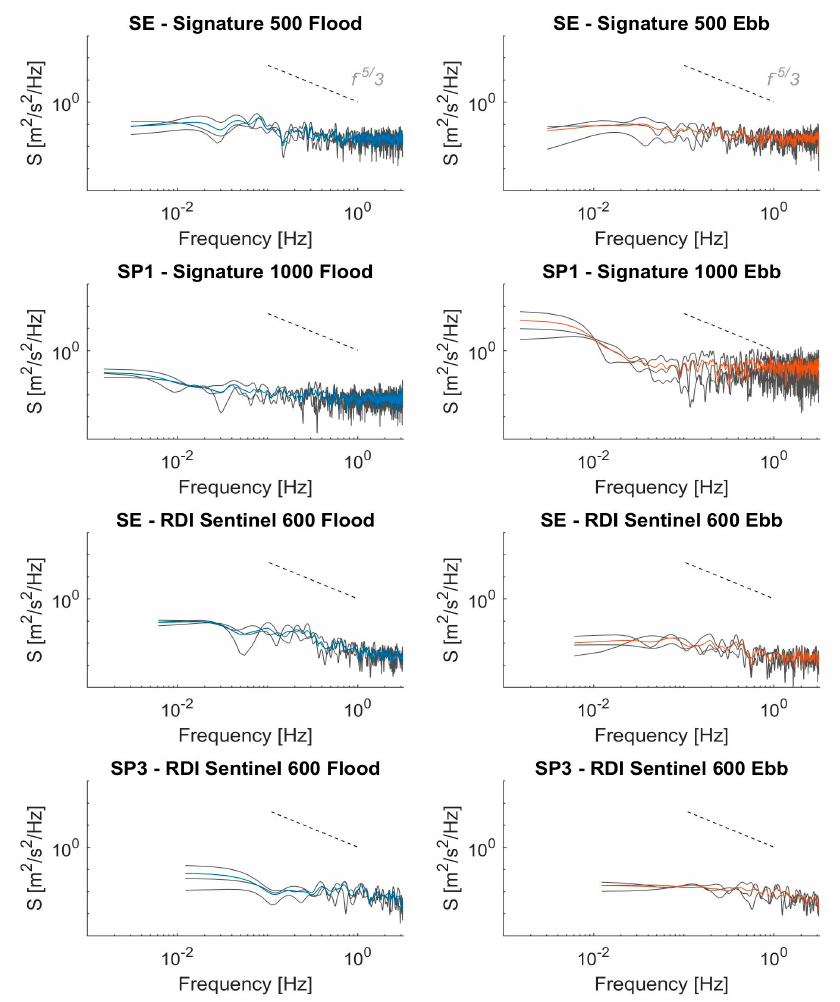
Figure 7. Average turbulence velocity spectra for each sensor during the peak flood (blue) and ebb (red) tide at 10 m from the seabed. The individual spectra for three instances are shown in grey for each sensor during the peak flood and ebb tide. The grey dashed line is included in each subplot to indicate the − 5/3 gradient of Kolmogorov’s turbulence energy cascade.